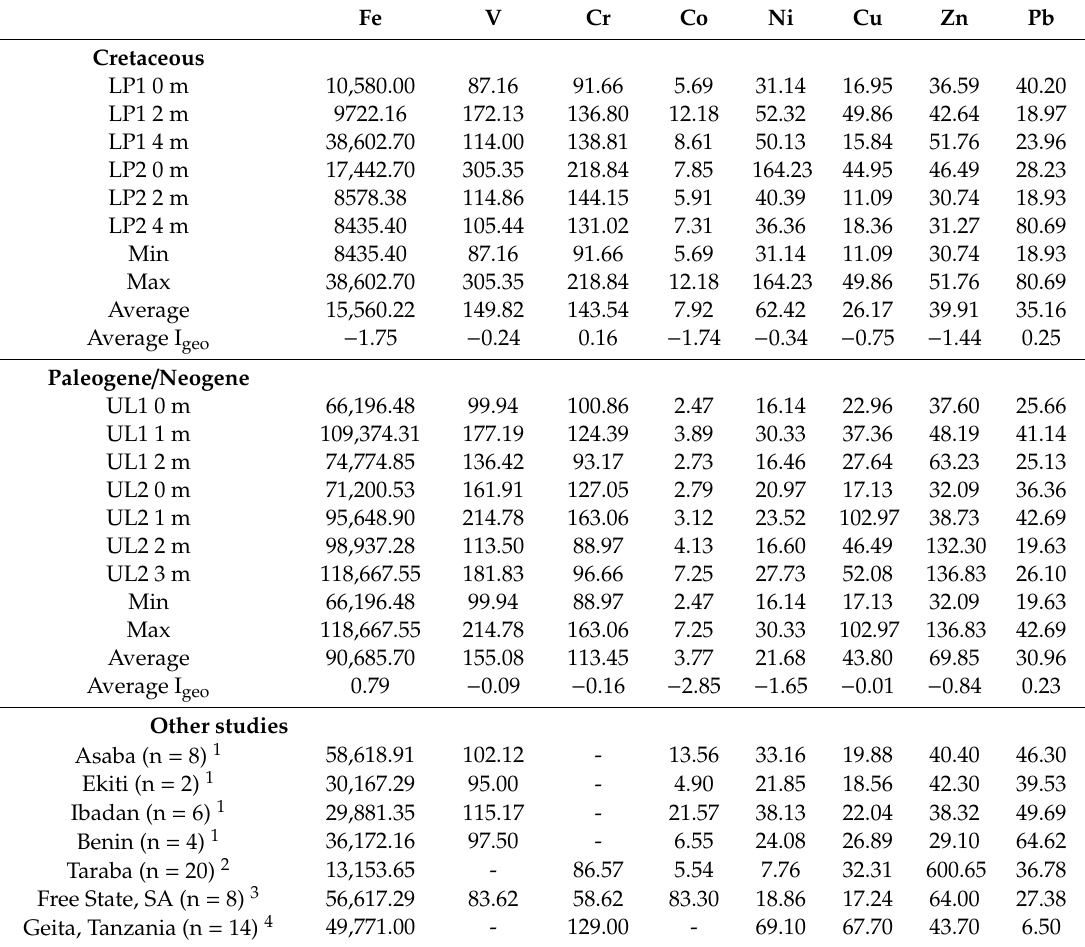
Table 2. Trace element concentrations (mg kg − 1 ) and average I geo of Cretaceous and Paleogene / Neogene geophagic clays from Eastern Dahomey and Niger Delta Basins, Nigeria, and averages for other studies from Nigeria, South Africa, and